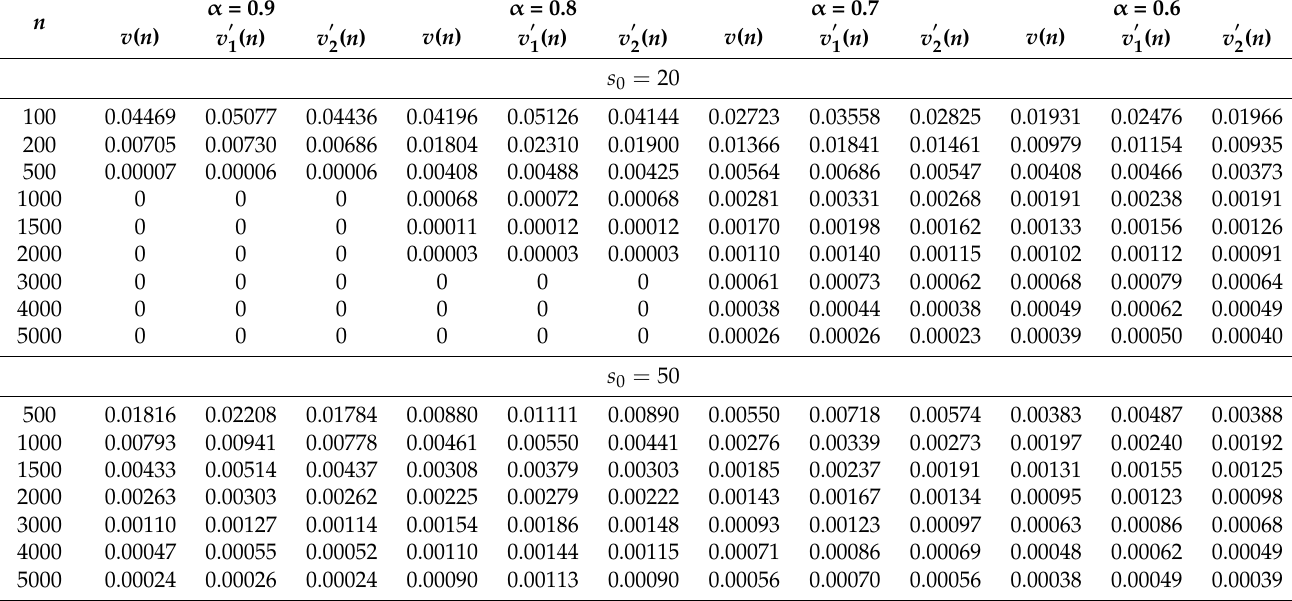
Table 1. Probability of Discovering New Shared Species. Numbers of species in two populations are s 1 = 100 & s 1 = 100, the number of shared species is s 0 = 20 or s 0 = 50, and species proportions follow Geom( α